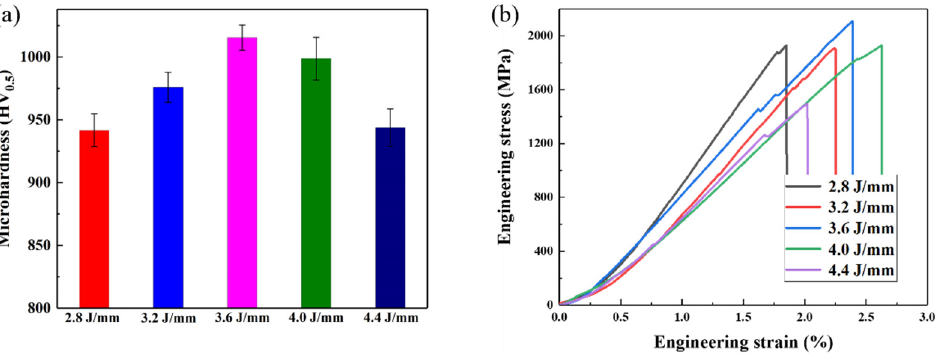
Figure 8. Property testing results of specimens at various processing parameters. ( a ) Average microhardness on cross-section of alloys, ( b ) engineering stress–strain curve of alloys at room temperature compression.